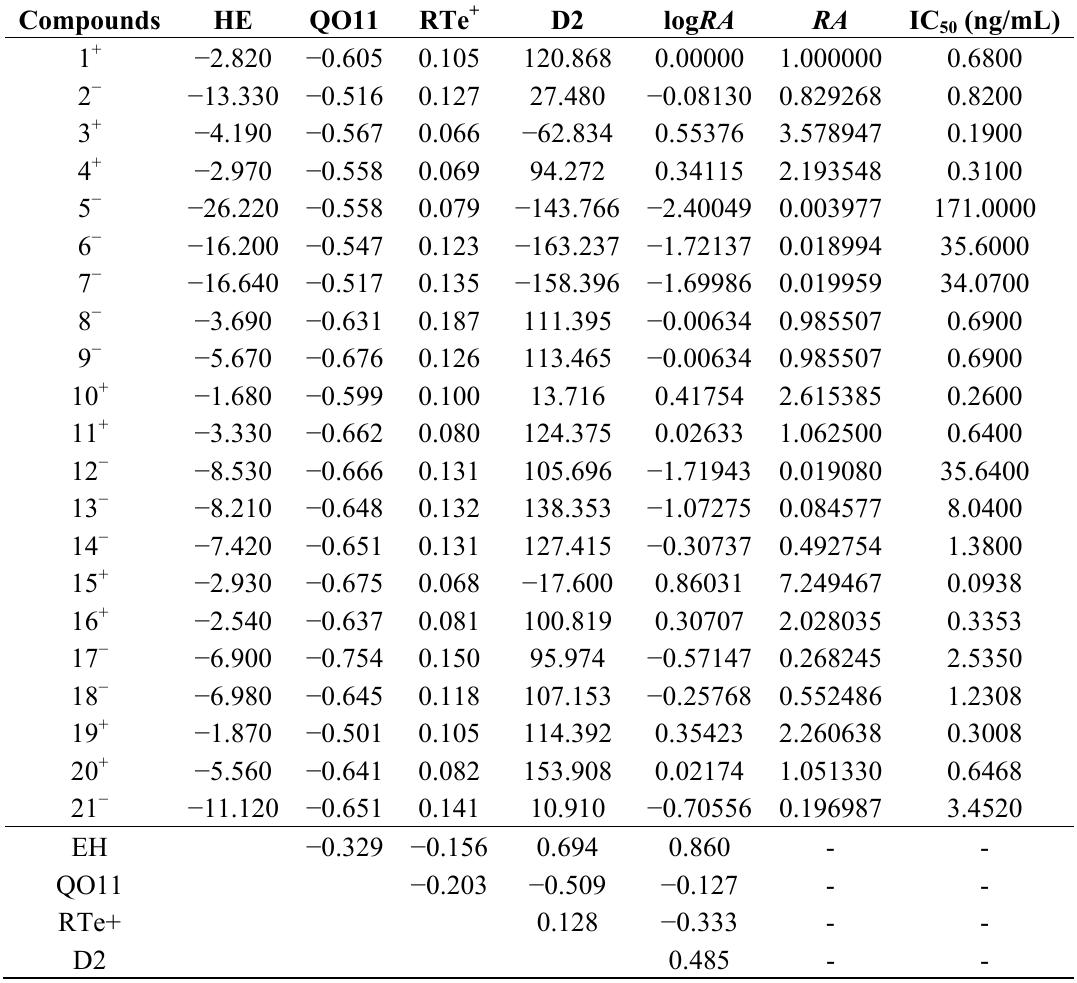
3. Physicochemical properties selected by principal component analysis, experimental log RA values, IC and the correlation 50